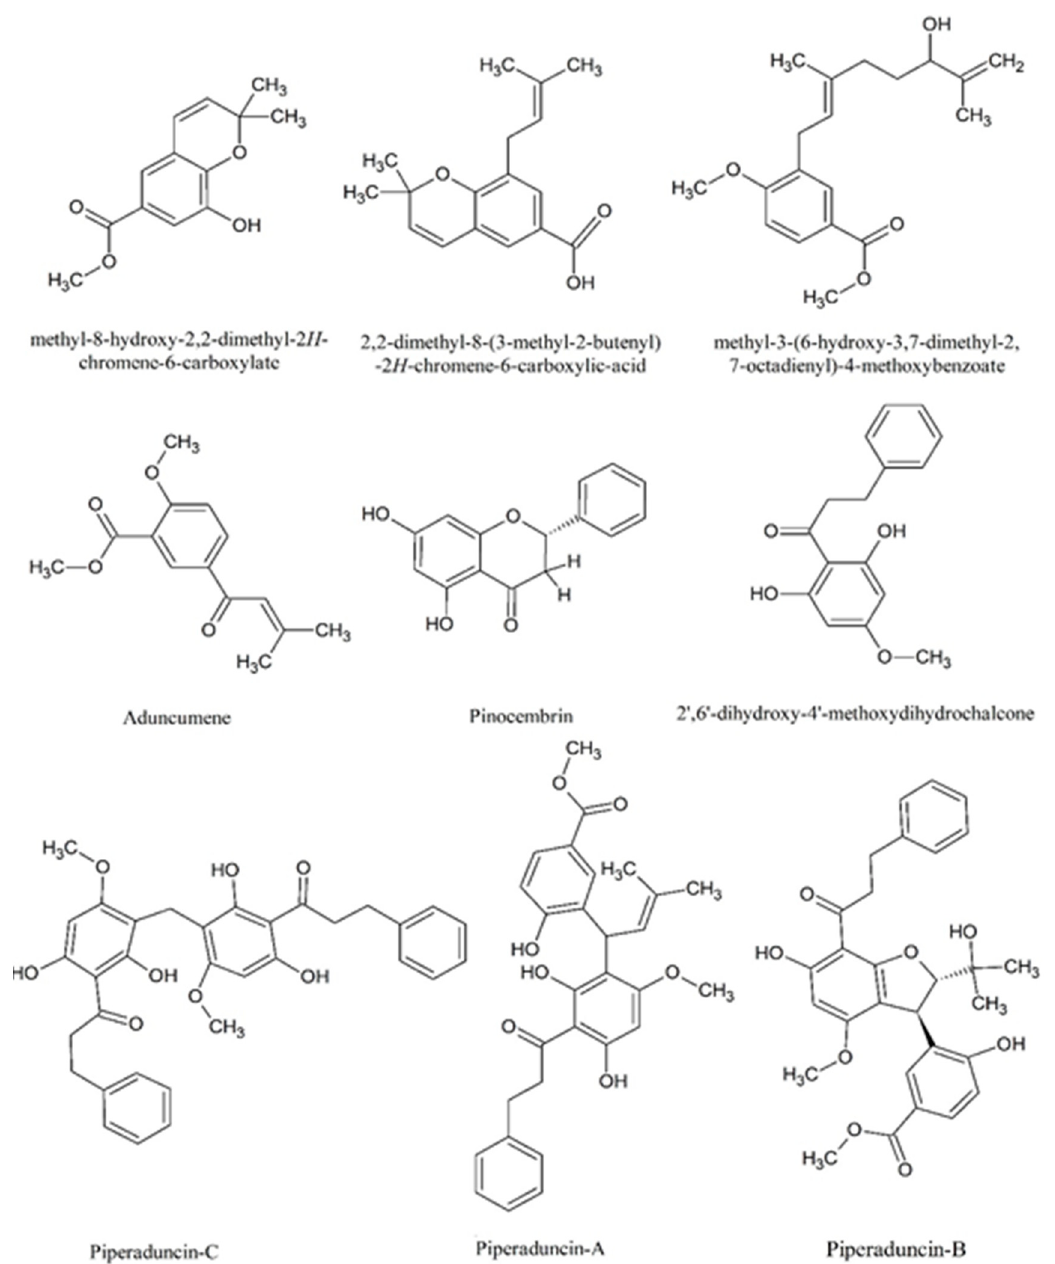
Figure 1. Main phytochemicals found in Piper aduncum L.